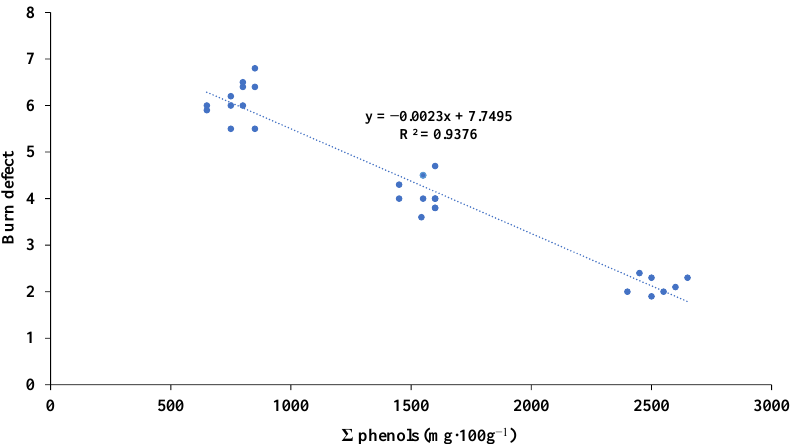
Figure 2. Linear regression for burn defects and Σ phenols in Californian-style black olive stuffed with hydrocolloids.